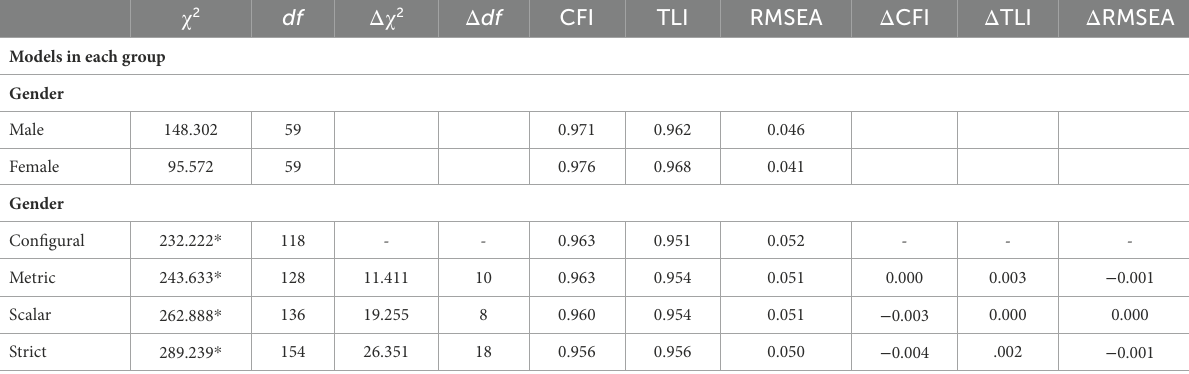
TABLE 6 Tested models and goodness-of-fit indices.